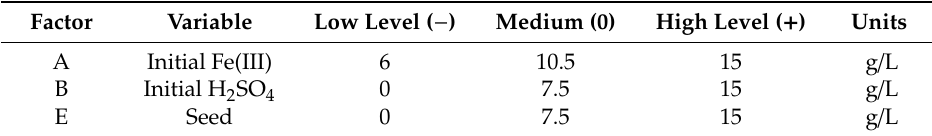
Table 3. Factors and their ranges used for the Box–Behnken